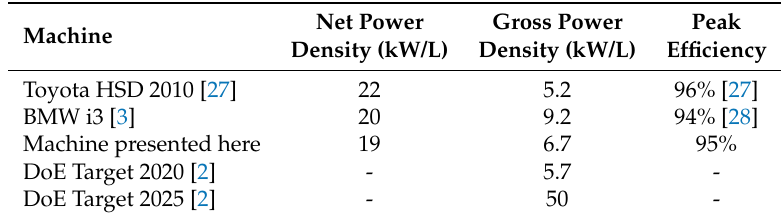
Table 1. Performance metrics for traction machines.